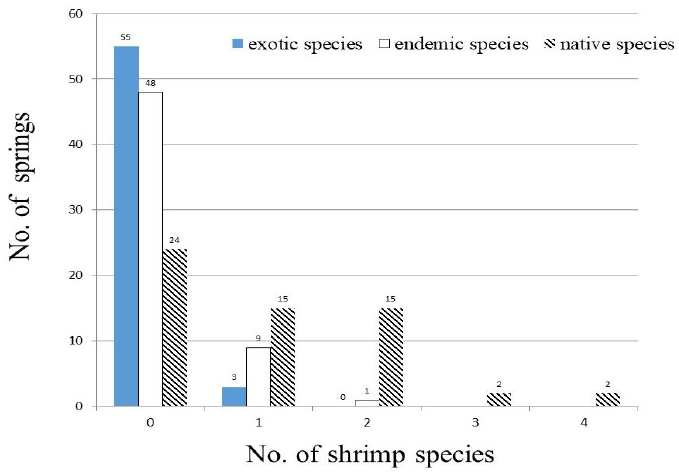
Figure 5. Occurrence frequency of 58 sampled springs for exotic, endemic, and native shrimp species.